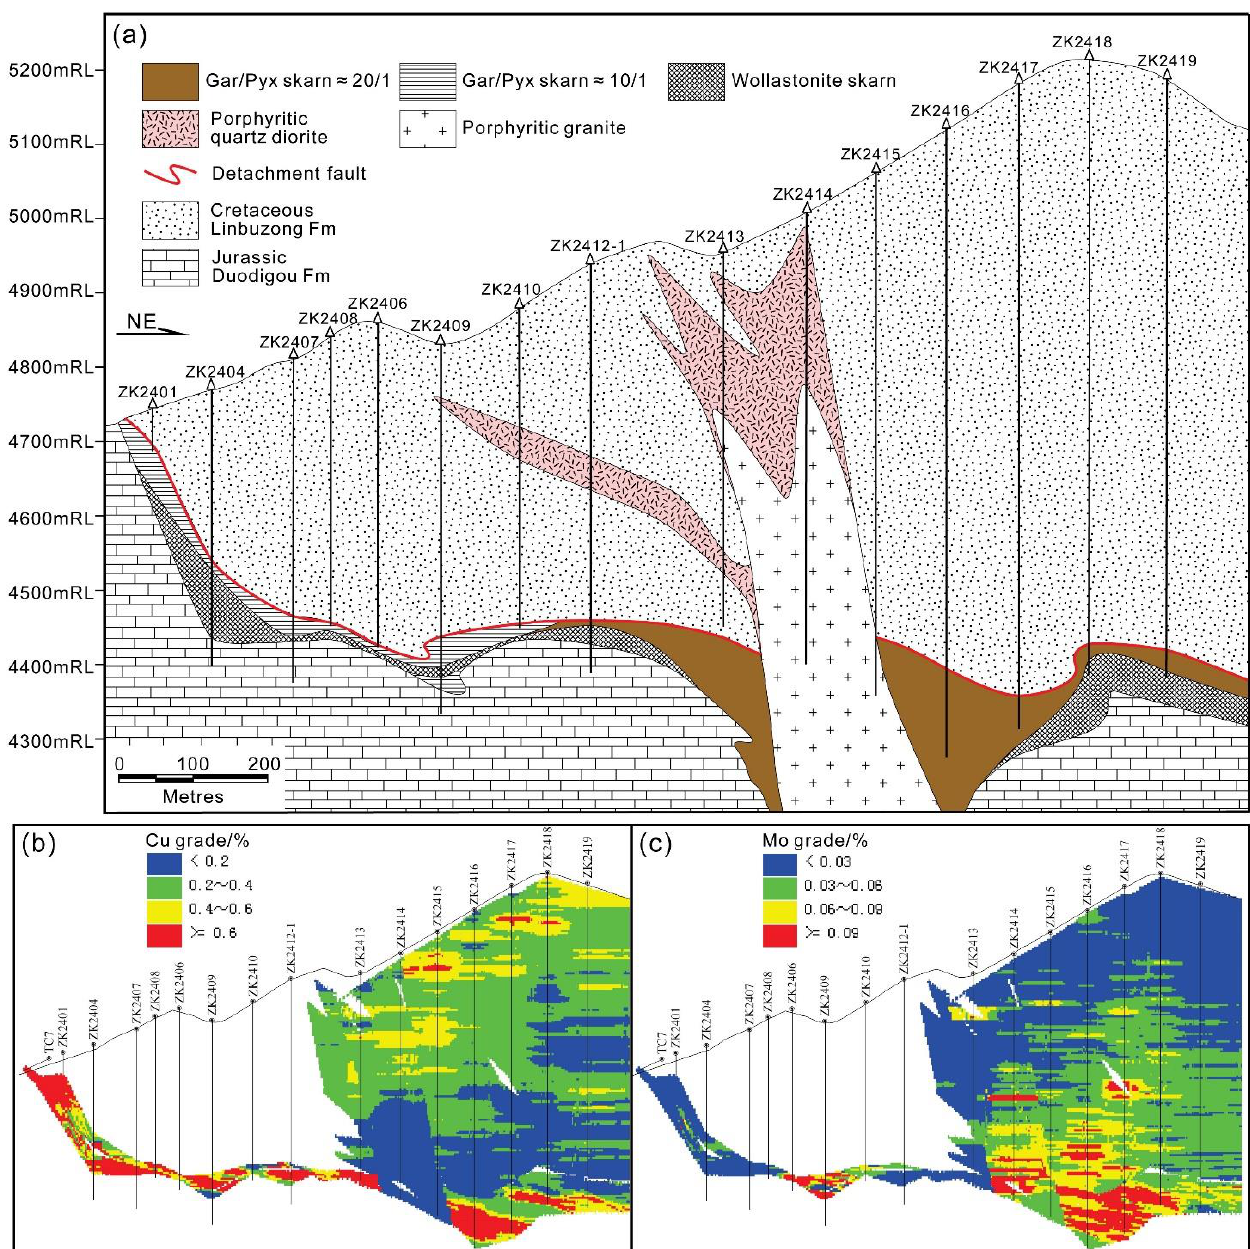
Figure 2. Cross-section No. 16 through the center of the porphyry–hornfels orebody. ( a ) Geological cross-section; ( b ) and ( c ) grade block models, showing the metal zonation characterizing the upper Cu and lower Mo zones in the porphyry– hornfels. The location of the section is shown in Figure 1b.